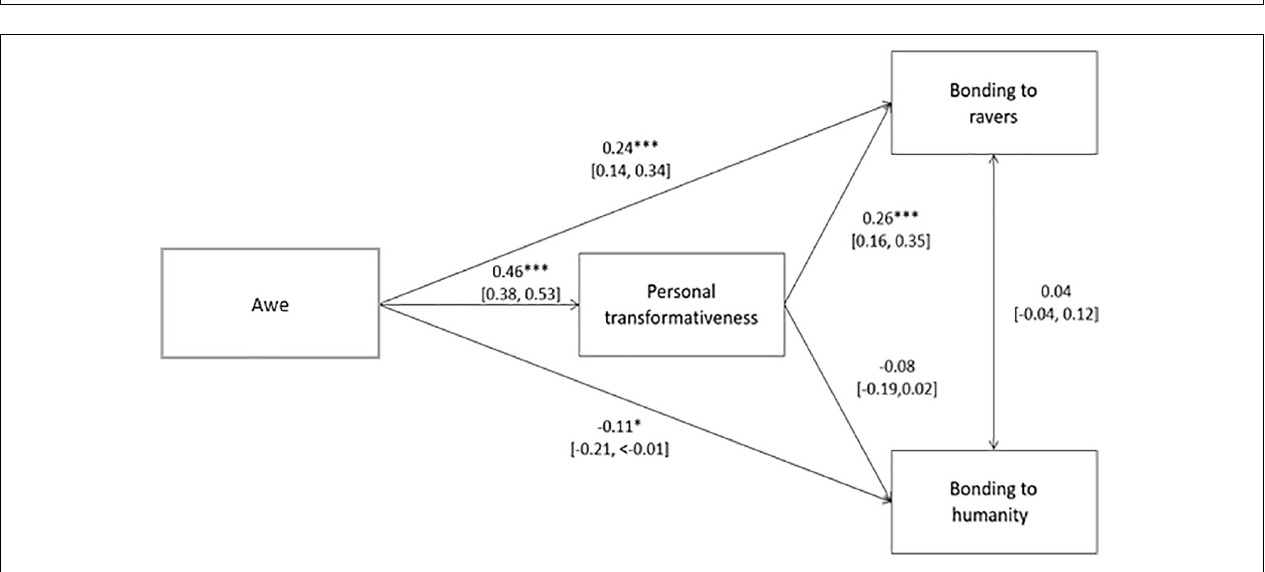
FIGURE 4 | Separate regressions of each of the 4D components onto each of the awe components (colored lines); only significant relations are shown.